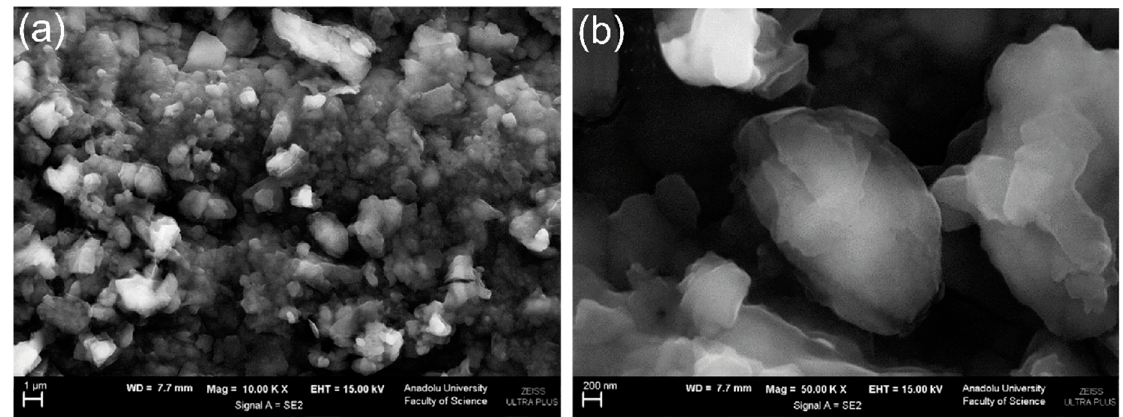
Figure 11. SEM image of p(P3CA)/PGE surface in a magnification of ( a ) 10,000 × and ( b ) 50,000 × . Modified with permission from [137]. Copyright 2015 Elsevier B.V.